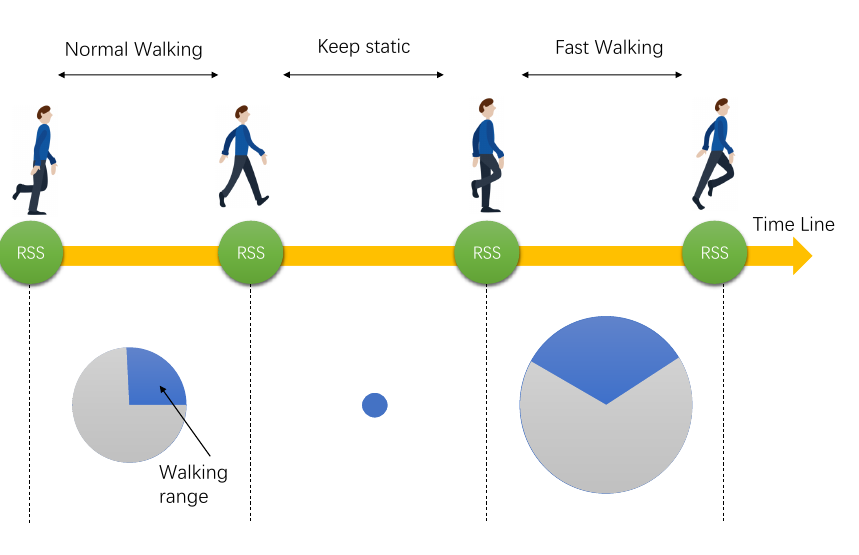
Figure 5. An example of a pedestrian’s possible walking status while constantly receiving the Wi-Fi RSS scans. Here, the walking speeds are classified into fast, static and normal modes, and each of the speeds corresponds to a predefined walk range denoted as the gray solid circle. Meanwhile, the range of the pedestrian’s walk direction between RSS scans is recorded and denoted as the blue